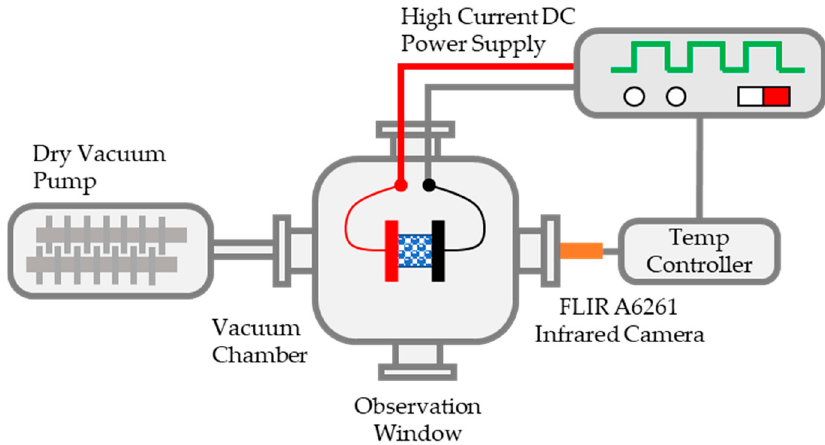
Figure 1. Schematic diagram of the fast-heating system.